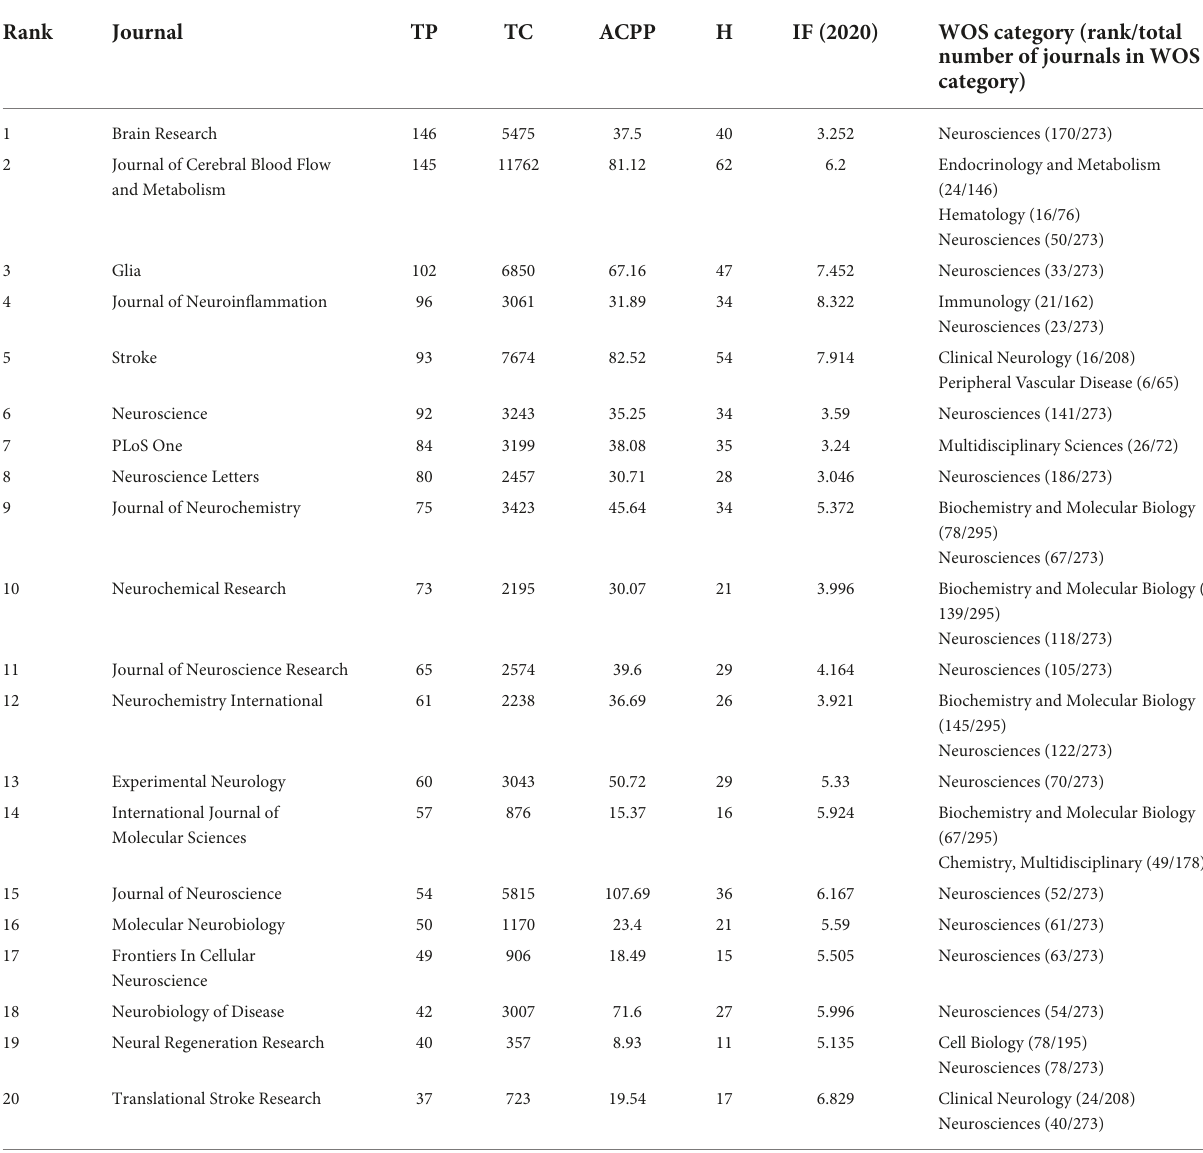
TABLE 3 Top 20 most productive journals in research on stroke and